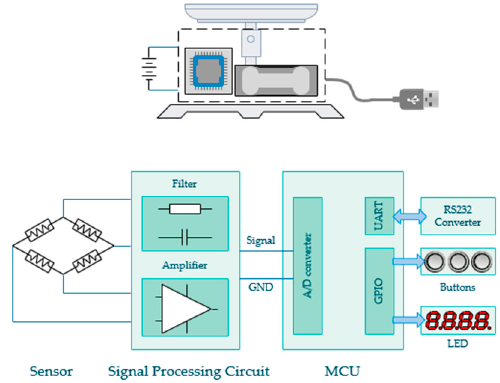
Figure 1. The experimental setup for the system.